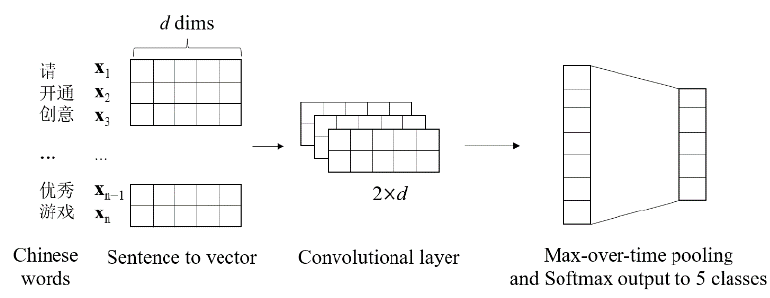
Figure 2. The structure of textCNN.